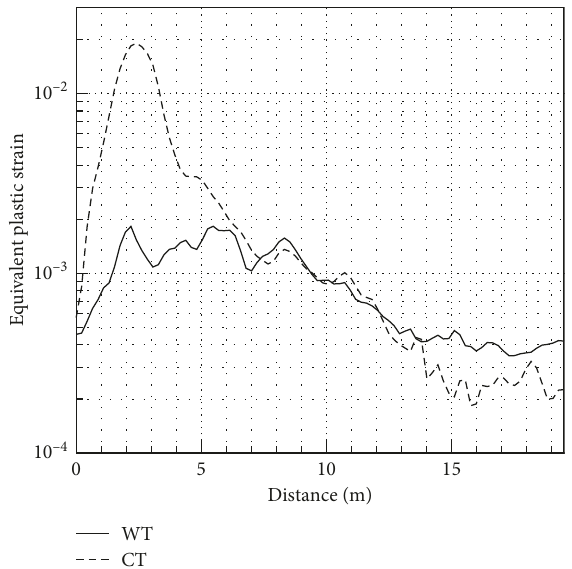
Figure 16: Equivalent plastic strain distribution on the inner surface of the containment along a circumferential path through point A (Figure 3) at